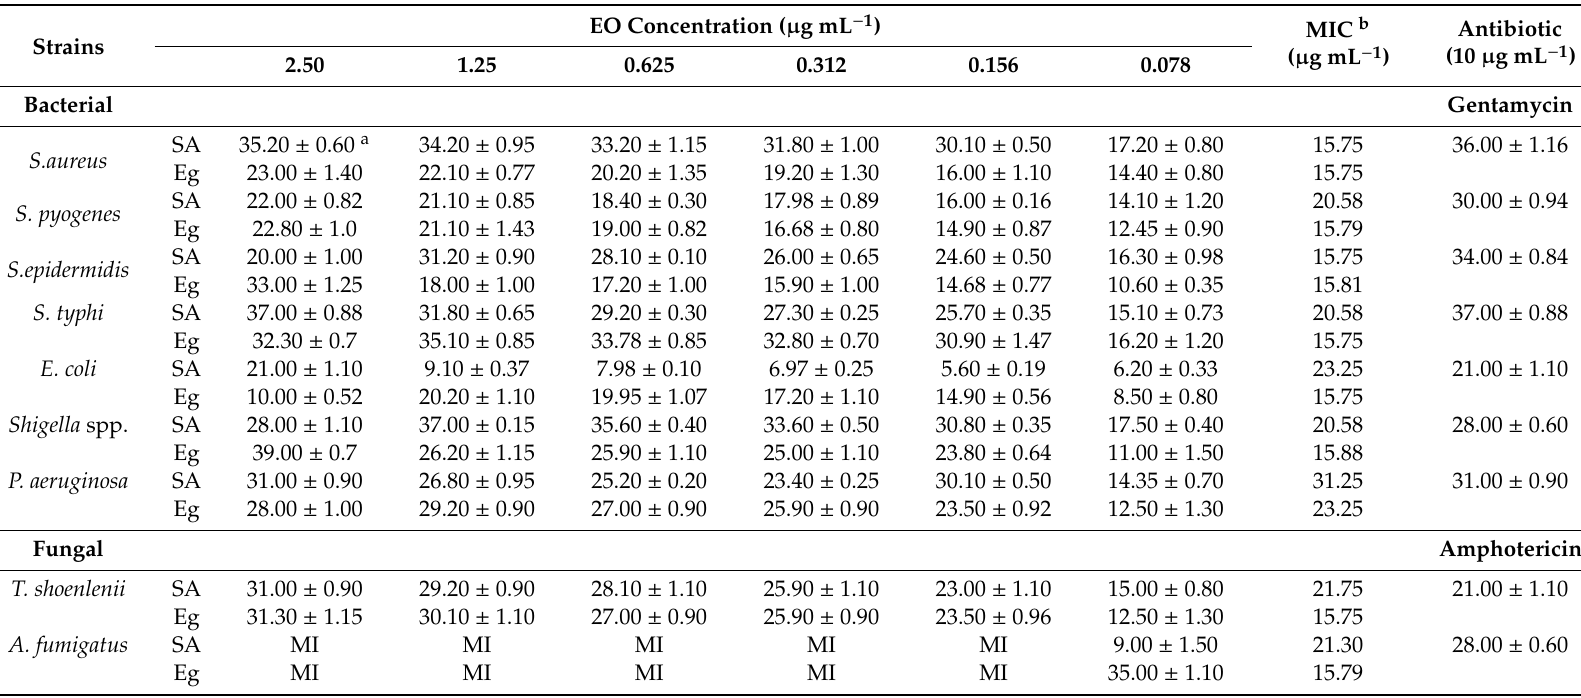
Table 2. Antimicrobial activity of the essential oils (EOs) extracted from Saudi (SA) and Egyptian (Eg) ecospecies of C. procera at di ff erent concentrations.